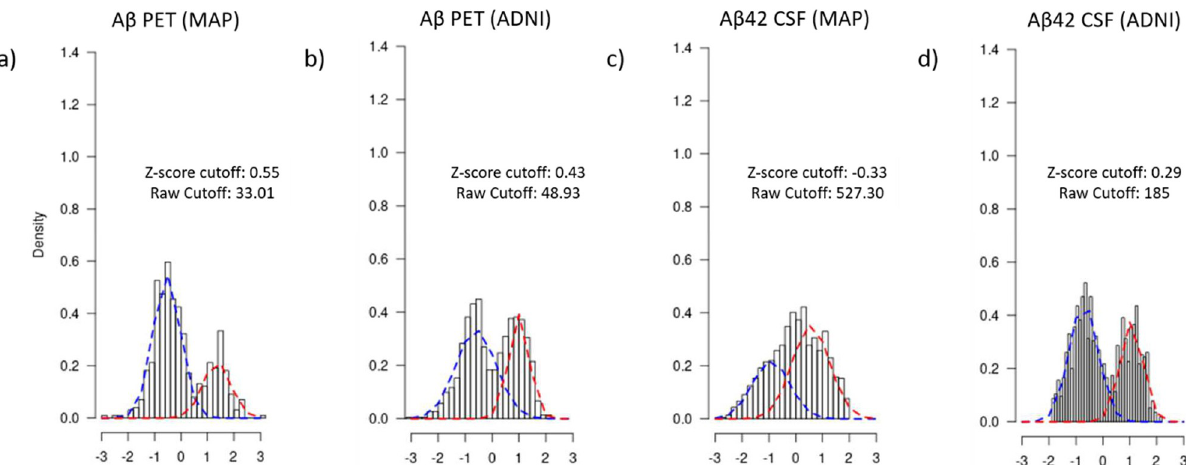
Fig 2. Cutoffs for dichotomizing different AD endophenotypes across MAP and ADNI cohorts. A density plot defining the dichotomization cutoffs for A β assessed by PET scan and A β 42 from CSF in MAP and ADNI cohorts. The distribution of z-score for cases and controls is shown by red and blue dotted lines, respectively. The cut-off point where both these distributions overlap was selected as the dichotomization threshold for each endophenotype. The dichotomization was performed on normalized z-scores for each endophenotype. However, the corresponding raw score for each dichotomization threshold is also labelled in the plot. Abbreviations: A β , β -amyloid; PET, positron emission tomography; MAP, Memory and Aging Project; ADNI, Alzheimer’s Disease Neuroimaging Initiative; CSF; Cerebrospinal fluid.